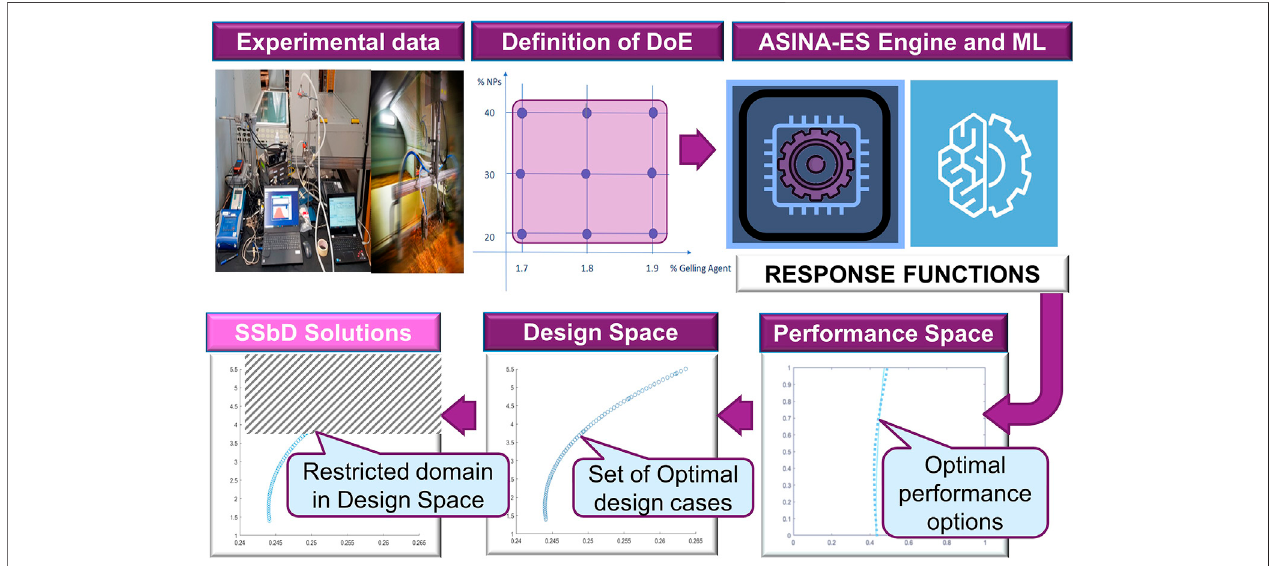
FIGURE 3 | The ASINA-ES modular architecture is based on (A) quantitative data, elaboration, and FAIRi fi cation of experimental data and their (B) further processing through the ASINA-ES platform and external machine learning regressors, which derive the response functions. (C) Based on the computational kernel (engine), the set of SSbD solutions are computed and reported through the ASINA-Graphical Users Interface (GUI). The suggested set of alternative solutions is a valuable support to the NEP designers ’ decisions process based on quanti fi ed expected performance in terms of product functionality, environmental and economic sustainability, as well as safety through the NEPs ’ LC